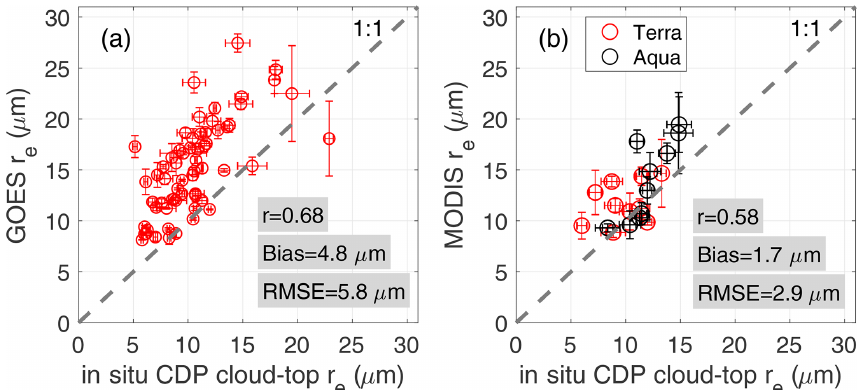
Figure 4. In situ CDP cloud-top effective radius against (a) GOES-13 and (b) MODIS. Linear correlation coefficient is denoted by r , bias is calculated relative to the in situ r e , and RMSE is the root mean square error. Statistics for MODIS combine data from Aqua and Terra. Dashed line represents the 1-to-1 relationship. Table 1. General r e statistics between satellite and CDP probe observations. Percentage values are relative to mean CDP values matched with the satellite data. GOES-13 vs. CDP MODIS vs. CDP Bias